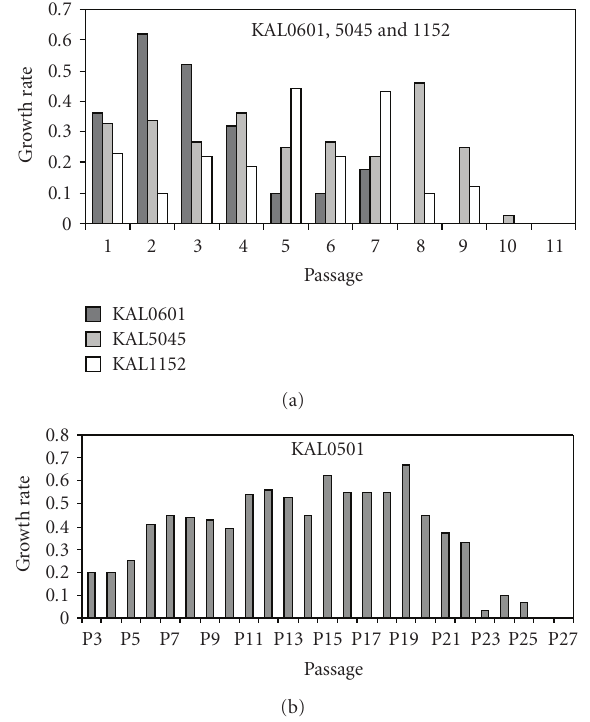
Figure 1: Growth rates of keratinocytes in function of passages. (a): growth rate of KAL 0501 from P1.